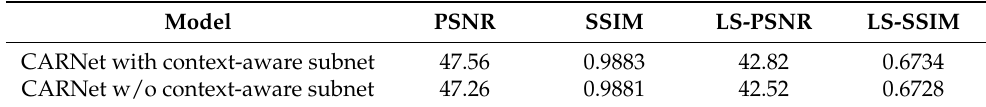
Table 6. Ablation studies of context-aware mechanism